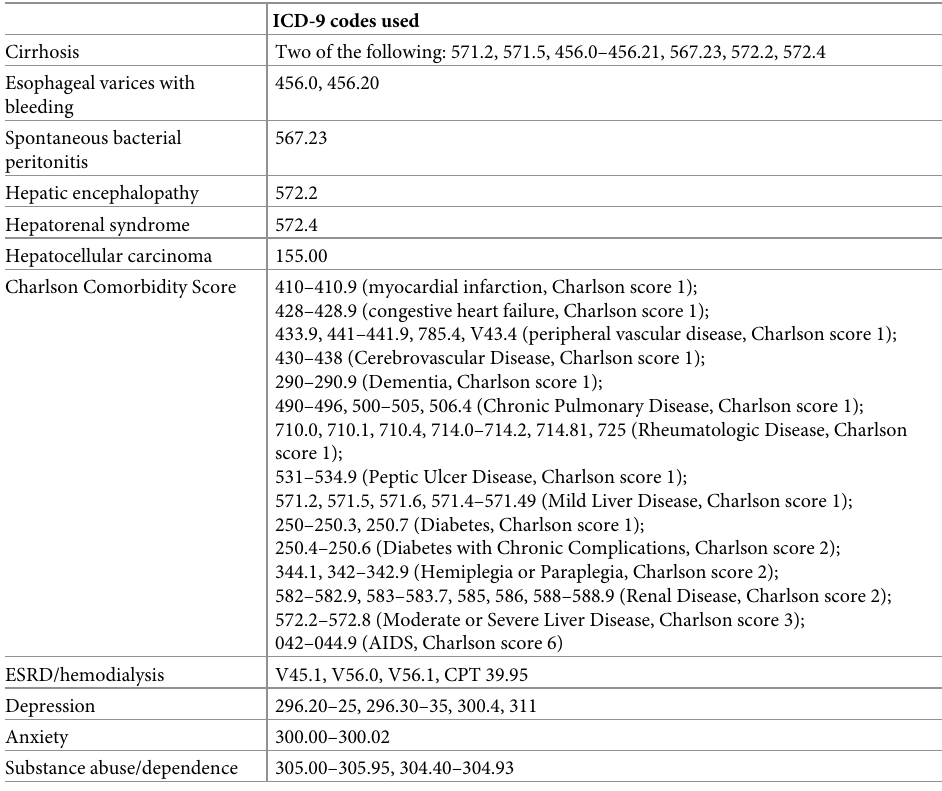
Table 1. ICD-9-CM coding